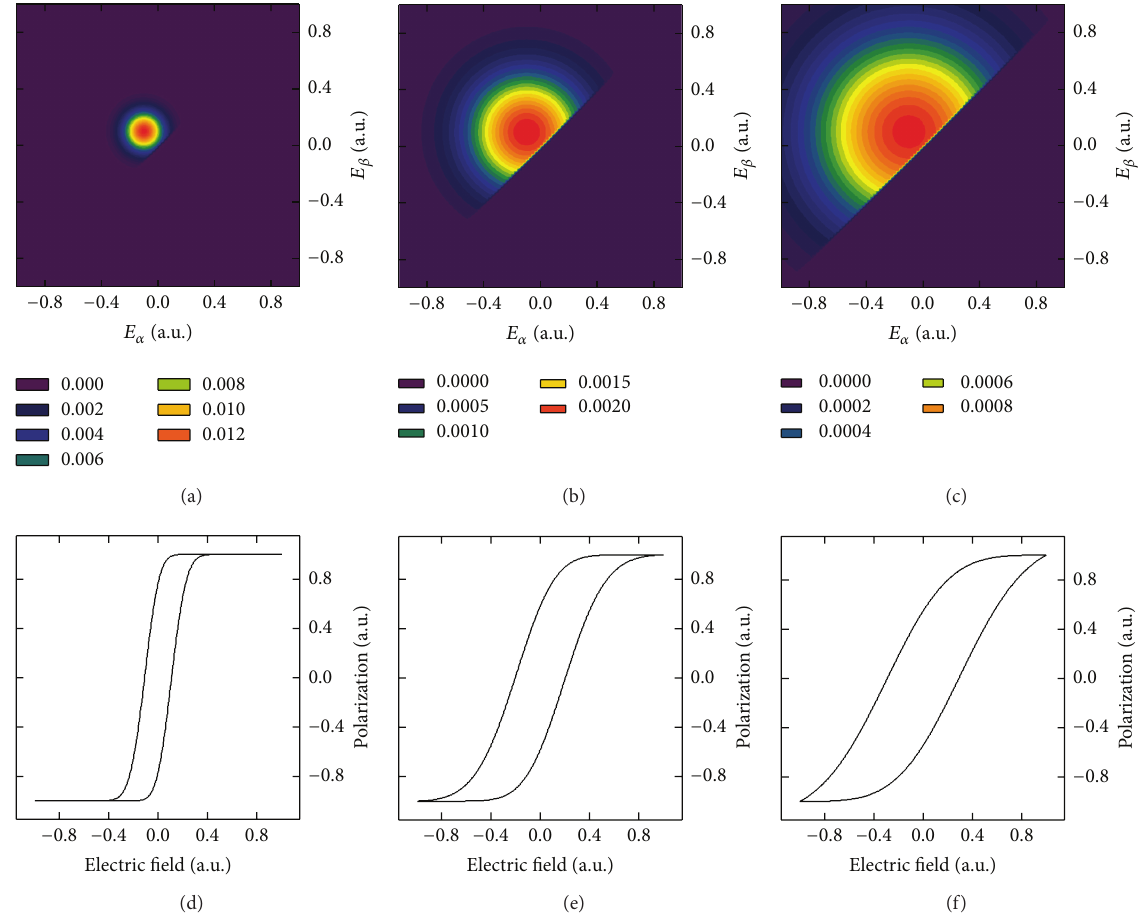
Figure 3: Gaussian-defined Preisach densities with centers located at ( − 0.1, 0.1) and width 𝜎 = (a) 0.10, (b) 0.30, and (c) 0.50. Their associated hysteresis loops are shown in (d), (e), and (f),